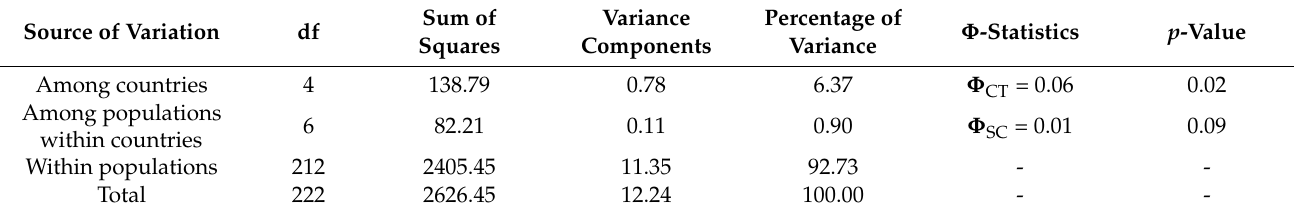
Table 4. Results of the AMOVA performed for the 11 population of Anax imperator sampled in the five European countries